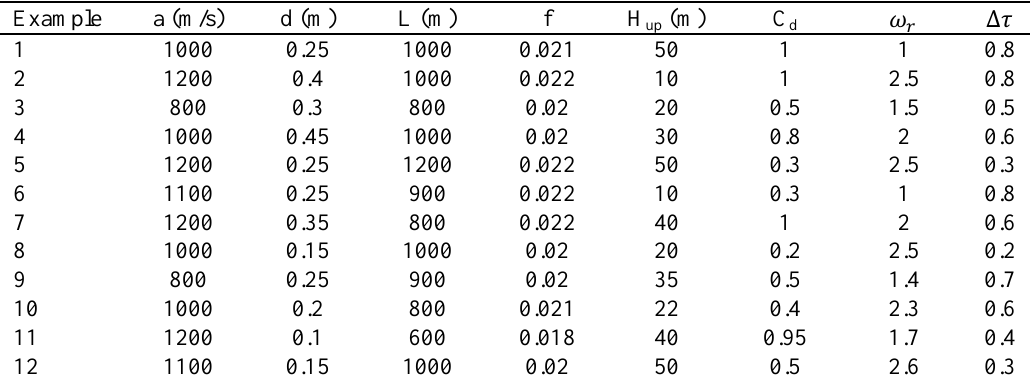
Table 2. Examples of the RPV